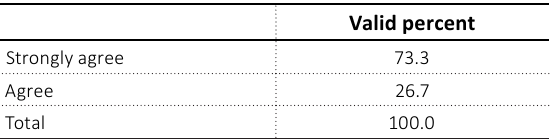
Table 2. Does KM add value to the division/